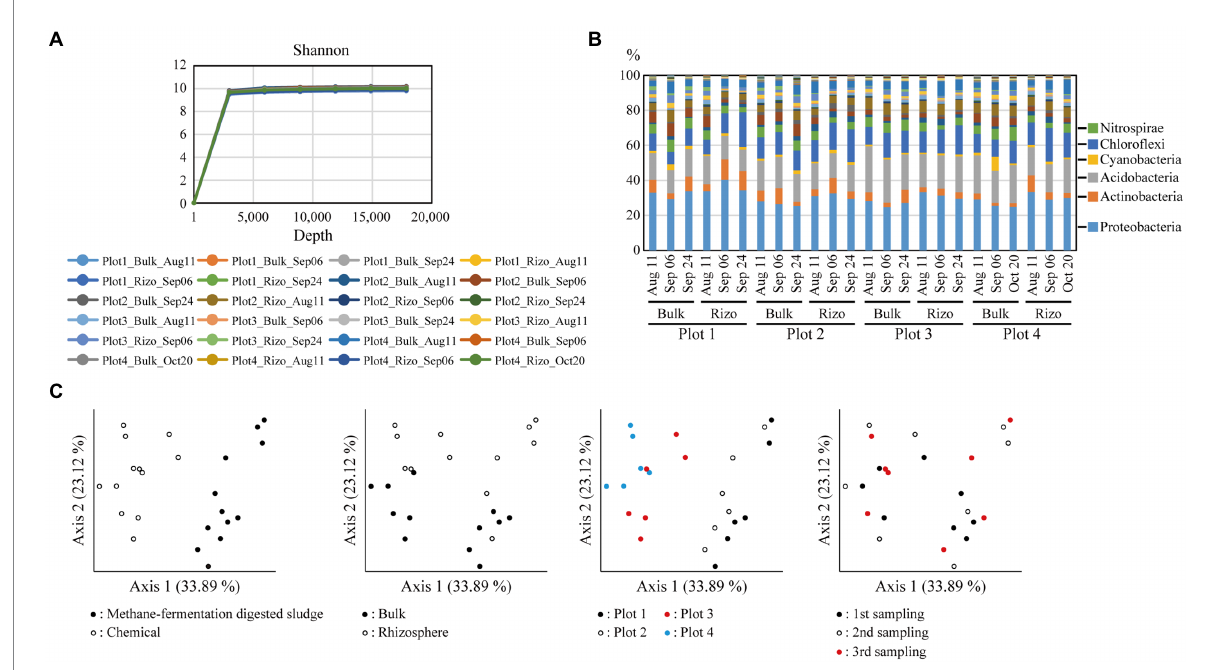
FIGURE 2 Diversity of soil bacterial communities. (A) Rarefaction curves of Shannon index on the sequencing depth based on the alpha diversity analysis. (B) Bacterial community compositions. Relative abundance of each phylum is shown in the graph, and the six major phyla are described to the right. (C) Weighted Unifrac principal coordinate analysis (PCoA) of the bacterial communities. Each graph is annotated according to each variable (cultivar., soil fraction, fertilizer type, or sampling time point). Rizo indicates